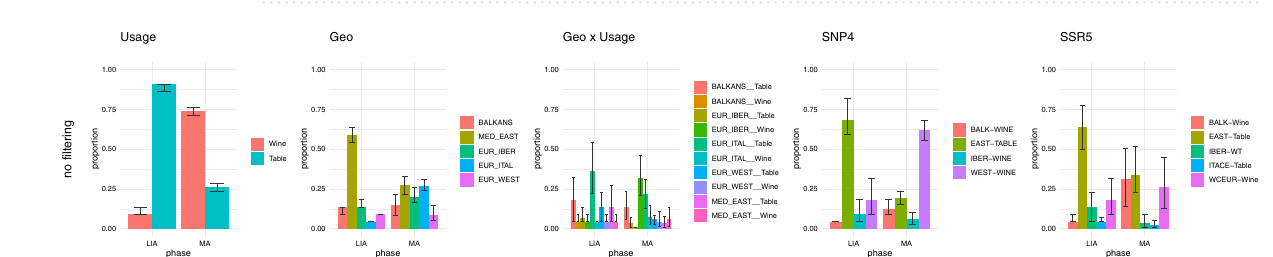
Figure 2. Confusion matrices for discriminant analyses. Cells present median percentages obtained over 100 permutations of balanced datasets. Along the diagonal, values in bold indicate significant values (i.e. above the maximal value obtained by chance alone among 100 permutations).